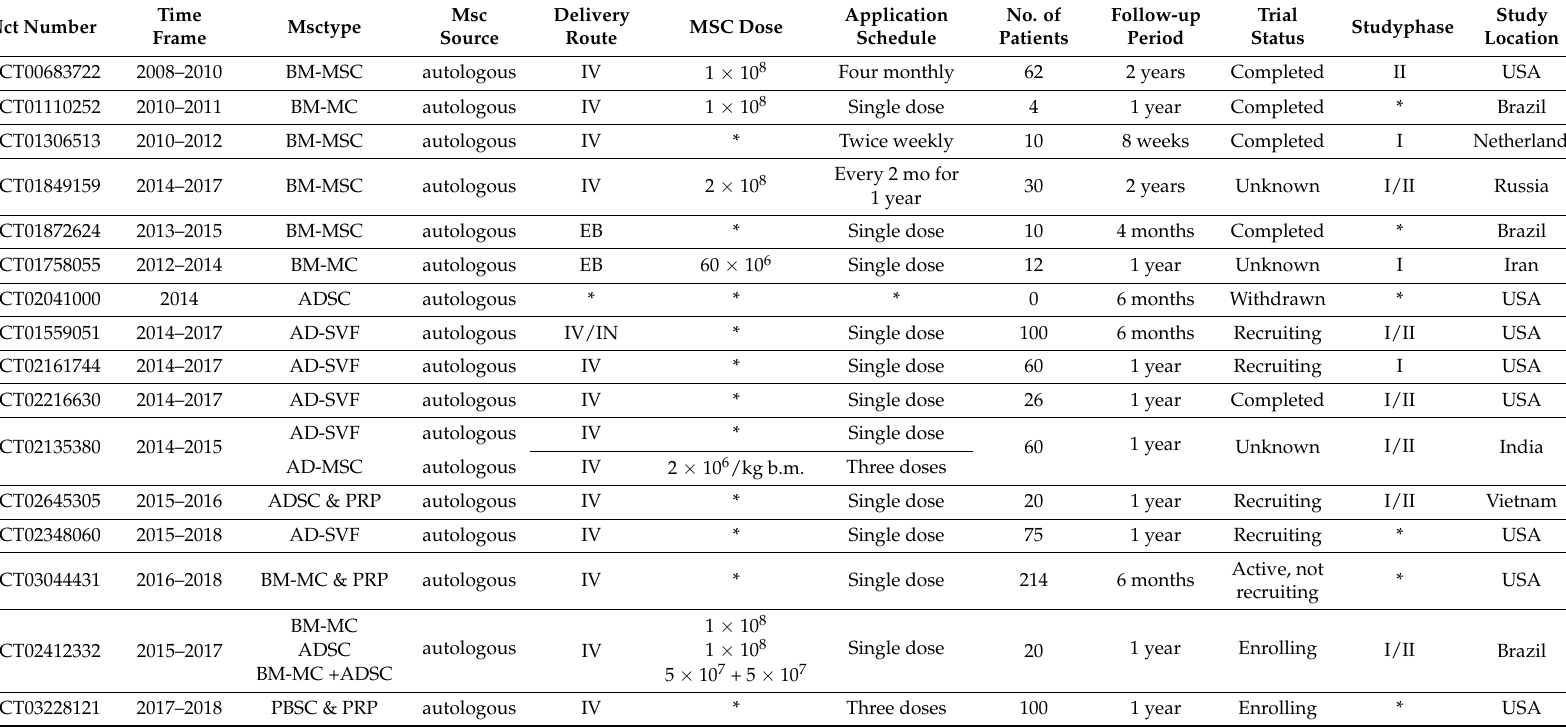
Table 2. Clinical trials using MSC therapies in COPD listed at ClinicalTrials.gov [79] as of 17 October